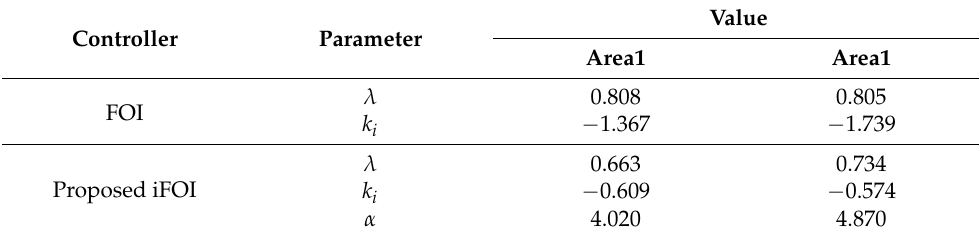
Table 2. Summary of the optimal values of the tested controllers based on GWO.